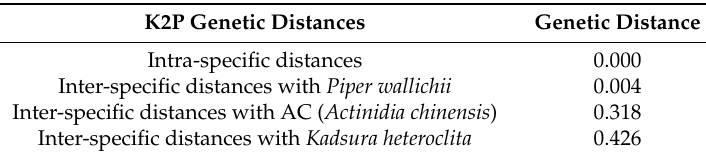
Table 1. Genetic distances within and between species.